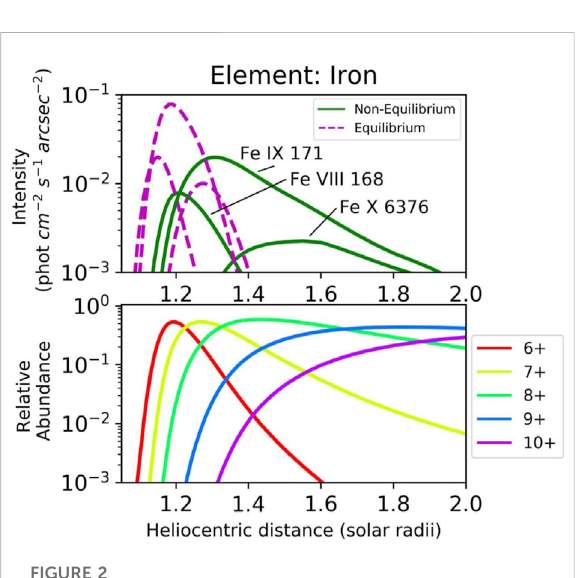
(Top) simulated intensities for equilibrium and non- equilibrium conditions and, (bottom) relative abundaces under non-equilibrium conditions within radially evolving solar plasma, adapted from Rivera et al.,